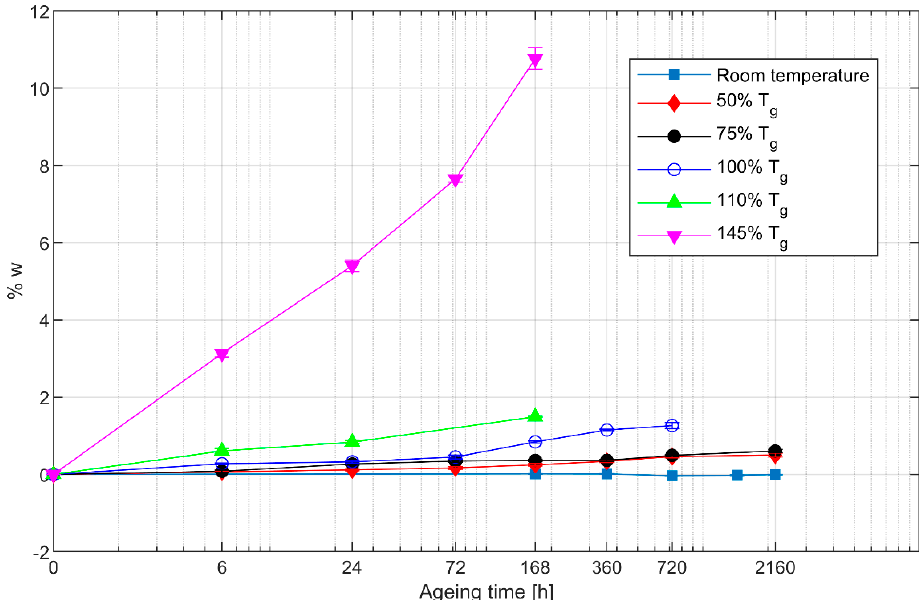
Figure 1. Results of weight loss measurements divided according to ageing temperature, expressed as a percentage of the glass transition temperature. The logarithmic scale on the horizontal axis has been adjusted so that the leftmost point represents the specimens in the unaged